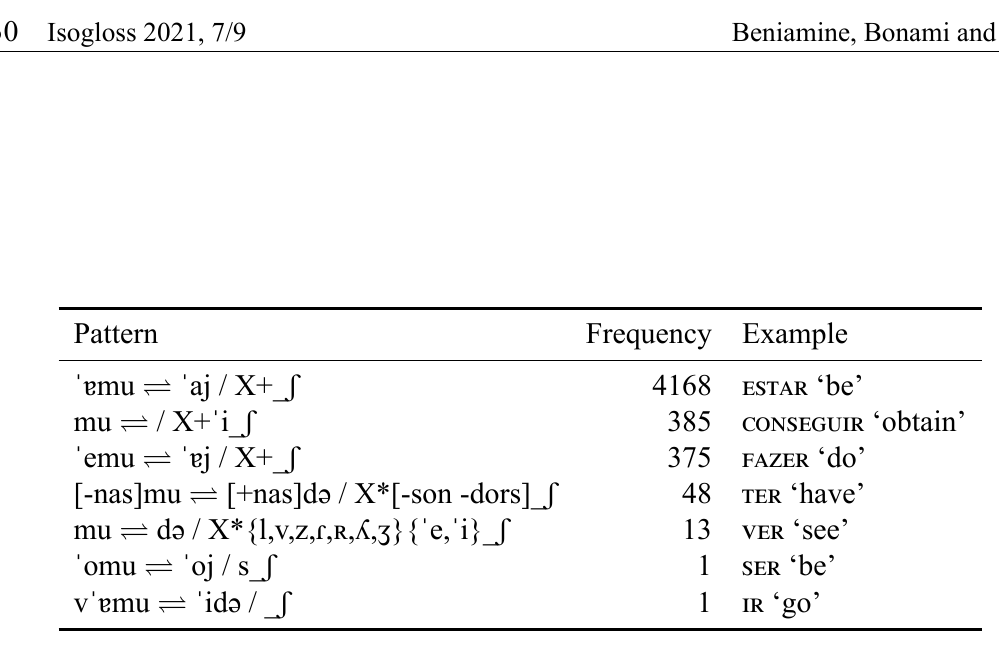
Table 23: List of patterns of alternation relating PRS.IND.1PL and PRS.IND.2PL